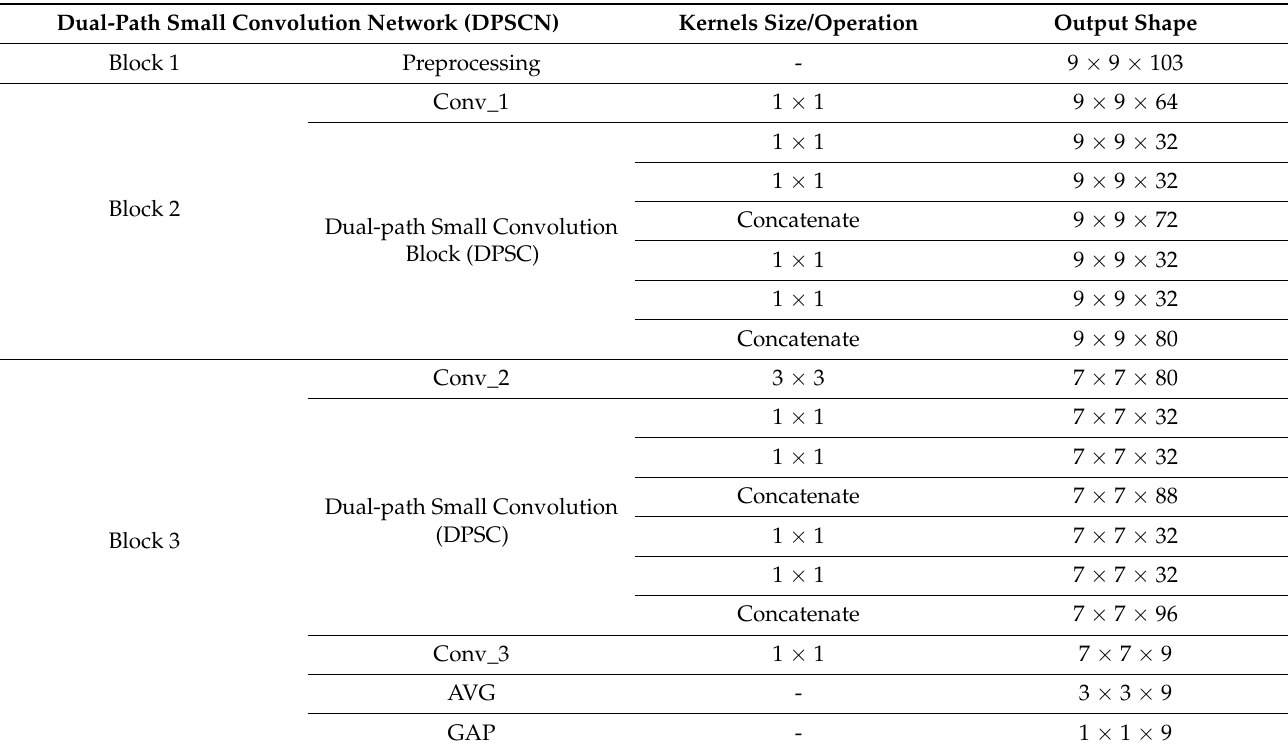
Table 1. The detailed configuration information of the proposed